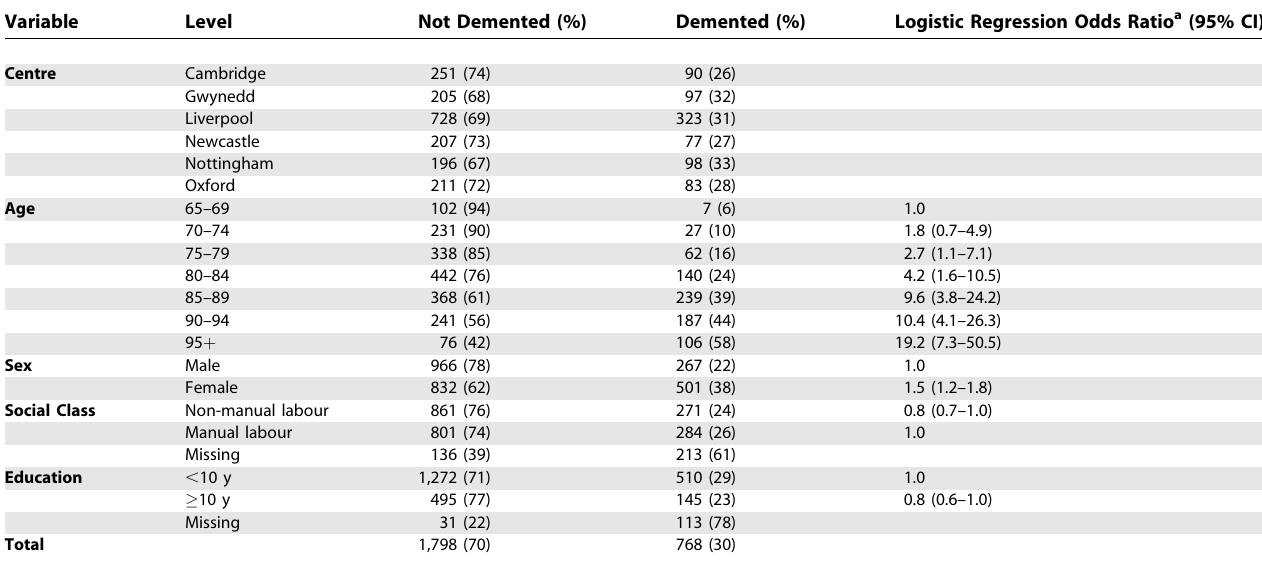
Table 1. Prevalence of Dementia at Death and Relationship to Potential Risk Factors for All Individuals Who Died within 1 y of Last